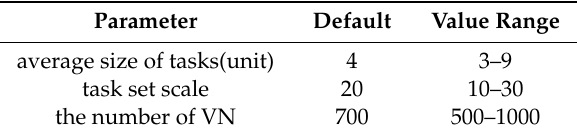
Table 2. Experimental default parameters.